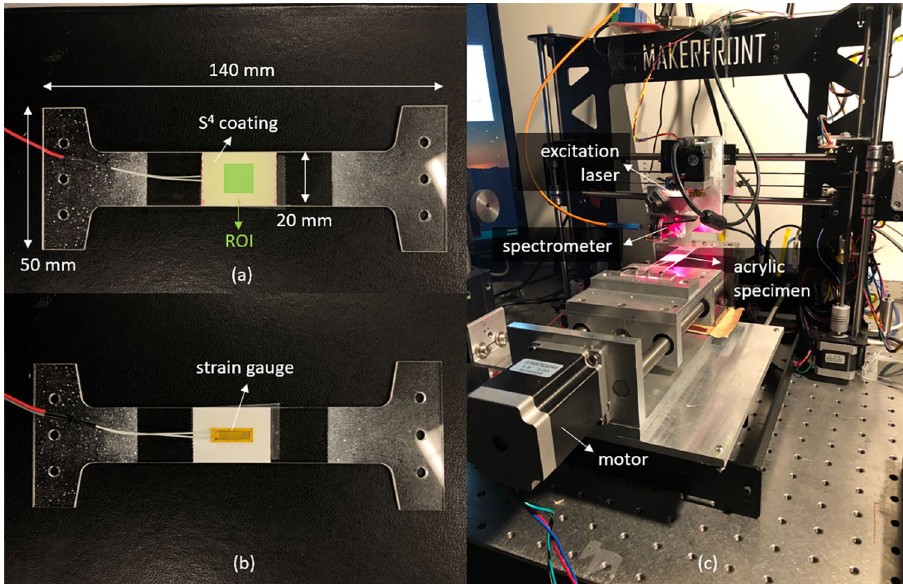
Figure 2. Photographs of ( a ) front face of the acrylic specimen with S 4 coating; ( b ) back face of the acrylic specimen with attached strain gauge; ( c ) experimental setup for specimen loading and S 4 data